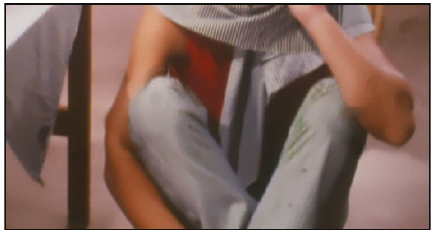
Figure 7: A chosen part of the inpainted geometry image.